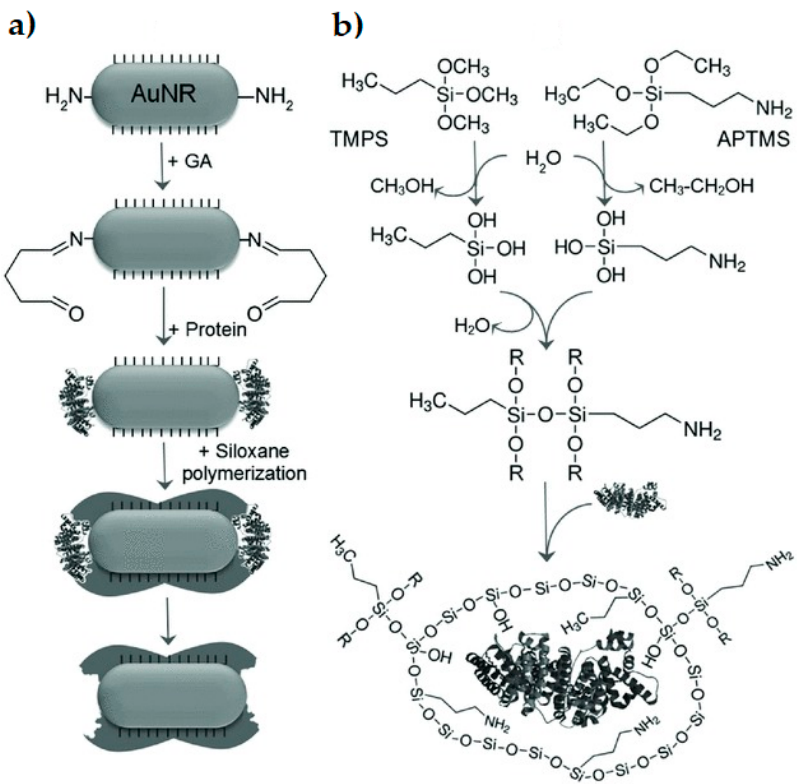
Figure 9. Preparation of the MIP ‐ based LSPR nanosensor by imprinting gold nanorods. ( a ) molecu ‐ lar imprinting steps: attachment of p ‐ ATP to the ends of the gold nanorod; glutaraldehyde (GA) interaction with the amine groups of p ‐ ATP on one side and with the amine groups of the protein on the other side; siloxane monomers polymerization in the presence of the protein templates. The release of the protein results in recognition cavities. ( b ) copolymerization of the organo ‐ siloxane monomers APTMS and TMPS. (Reproduced with permission from [85], Copyright © 2013 WILEY ‐ VCH) .